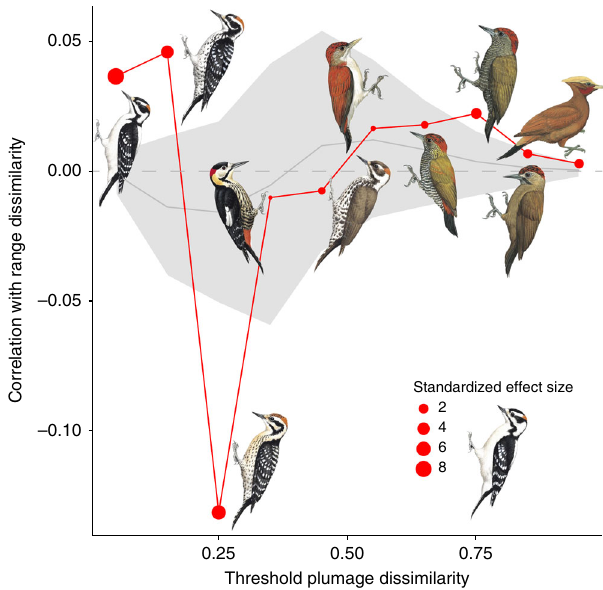
Fig. 4 Modi fi ed Mantel correlogram shows how correlation of range and plumage changes across varying plumage dissimilarity. For dyadic comparisons with plumage dissimilarities of 0 – 0.2, geographic range overlap per se is statistically signi fi cantly associated with increasing plumage phenotype matching between already similar looking species pairs. The relationship was reversed at intermediate levels of plumage dissimilarity, where geographic range overlap is statistically signi fi cantly associated with decreasing plumage phenotype matching between somewhat similar looking species pairs (plumage dissimilarities of 20 – 30%). Illustrations show examples of species with plumage dissimilarities in the range indicated as compared with the Downy Woodpecker ( Dryobates pubescens ) inset in the legend. The red line shows the observed correlation coef fi cients, while the shaded grey area shows the expected correlation coef fi cients given the simulations described in the text. The size of the red circle corresponds to the standardized effect size of the observed correlation coef fi cient; values greater than + / − 1.96 deviate beyond 95% of simulated values. Illustrations © HBW Alive/Lynx